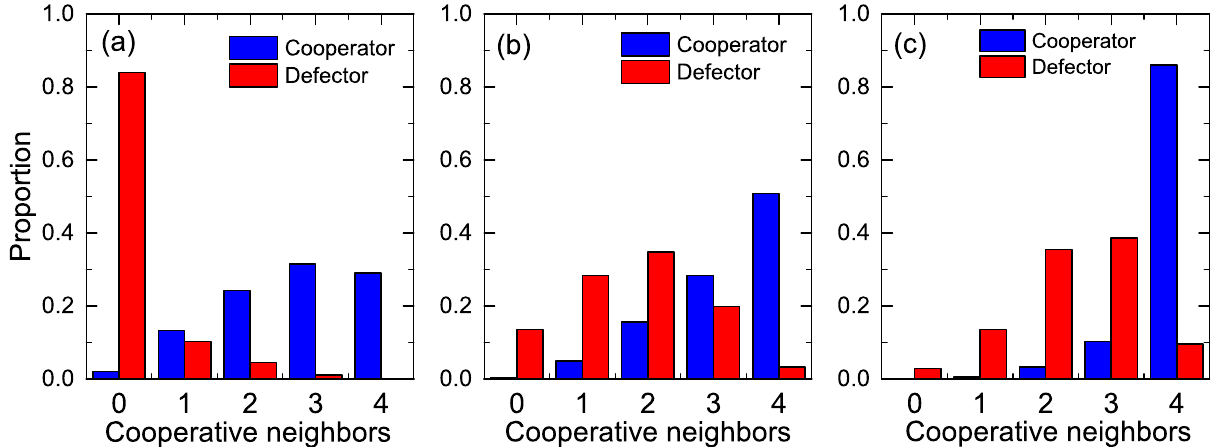
Fig 5. Distribution of cooperative neighbors of focal cooperators and focal defectors. Results of focal cooperators and focal defectors are denoted by blue and red columns, respectively. From (a) to (c), the values of ε are 0.0, 0.5, and 1.0, respectively. The game parameter b is fixed to 1.02.